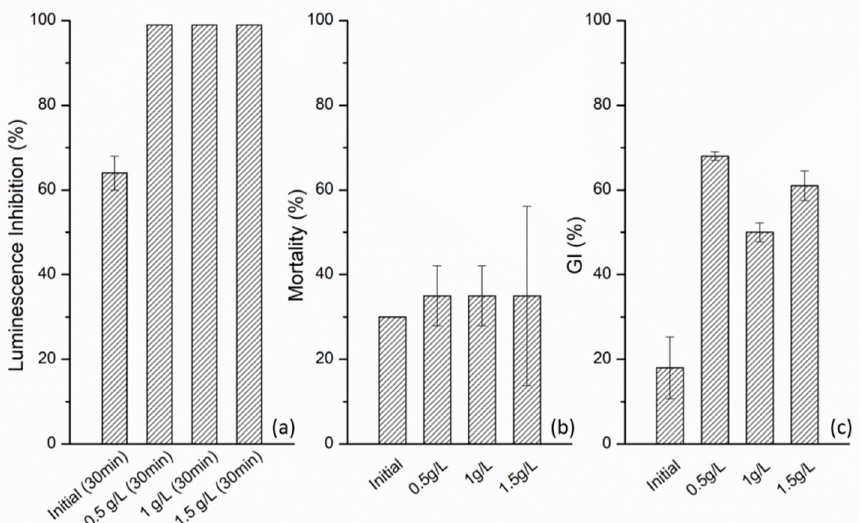
Figure 6. Luminescence inhibition of A. fischeri ( a ), mortality of C. fluminea ( b ) and germination index of L. sativum ( c ) for the initial phenolic acids mixture and different RM concentration (0.5, 1 and 1.5 g/L) (pH 3.4; concentration of H 2 O 2 = 100 mg/L).